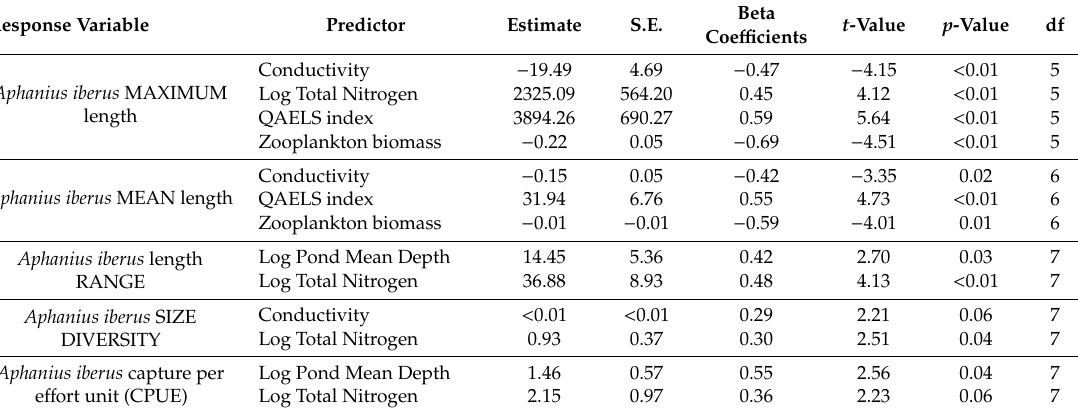
Table 3. Results of the linear mixed models (N = 49 fyke nets) showing the predictor variables that significantly relate with Aphanius iberus size metrics and abundance (expressed as CPUE). Only the most parsimonious significant models were shown for each response variable. For each model, the intercept (estimated and standard error, S.E.), beta coe ffi cients (standardized), t -value, significance ( p -value) and degrees of freedom (df) are also